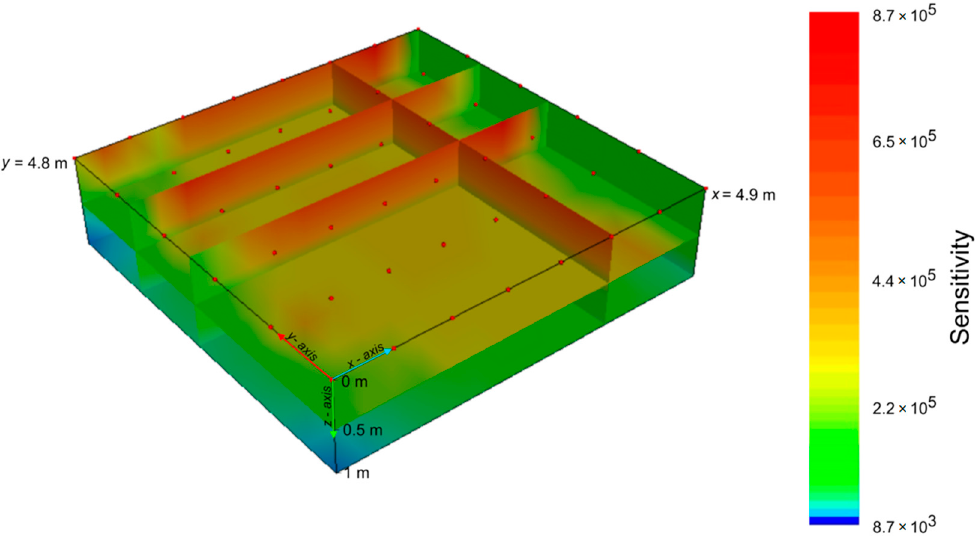
Figure 3. Sensitivity analysis performed on ERT data.